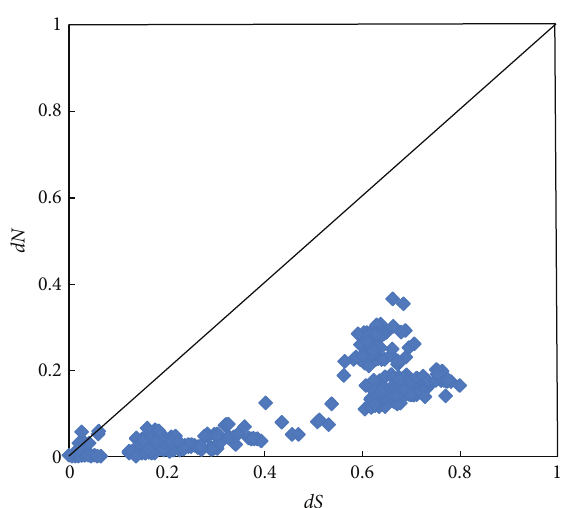
Figure 2: Phylogenetic tree and motif distributions of FKBP25.